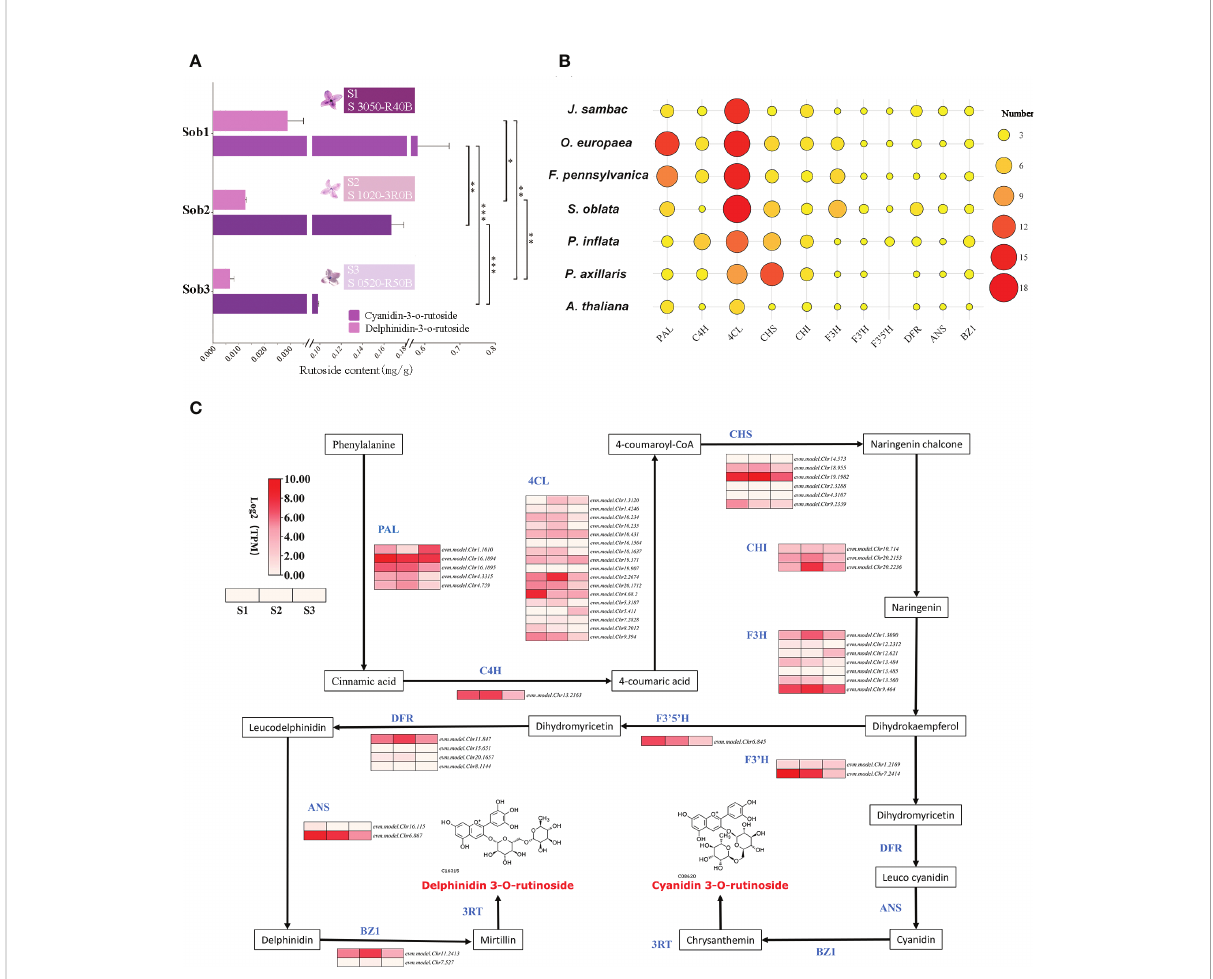
FIGURE 4 Analysis of molecular mechanism of fl oral color differences among S. oblata individuals. (A) The content of delphinidin-3-O-rutinoside and cyanidin-3-O-rutinoside of different S. oblata individuals. (B) Heat map of the number of delphinidin-3-O-rutinoside and cyanidin-3-O-rutinoside biosynthesis-related genes in different species. (C) The biosynthesis pathway and the expression pro fi le for delphinidin-3-O-rutinoside and cyanidin-3-O-rutinoside in S. oblata individuals. T test (* : P ≤ 0.05, ** : P ≤ 0.01, *** :P ≤ 0.001) was used for statistical analyses; mean ±